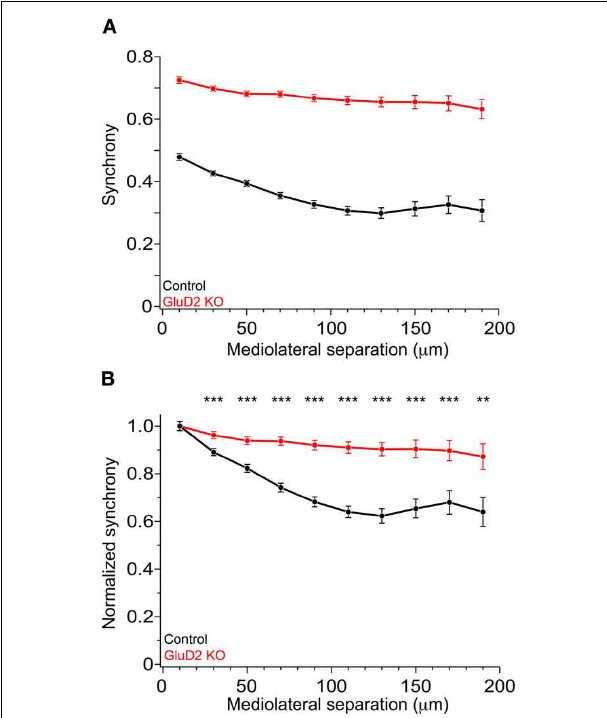
FIGURE 2 | Enhanced synchrony between dendrite pairs of GluD2 KO mice at all the distances of mediolateral separation. (A) Summary graph showing pooled data of synchrony plotted against the mediolateral separation for 1009 dendrite pairs obtained from 33 control mice (black symbols) and for 1064 dendrite pairs from 26 GluD2 KO mice (red symbols). Each data point represents the average of synchrony and error bars indicate SEM. There was significant difference between the two genotypes ( p < 0 . 001 by Two-Way ANOVA). (B) All values of synchrony were normalized by the mean value of the nearest dendrite pairs within the mediolateral separation of 20 μ m. There were significant differences between the two genotypes in all but the nearest pairs ( ∗∗ p < 0 . 01, ∗∗∗ p < 0 . 001 by Two-Way ANOVA and Tukey test), indicating that the degree of decline in synchrony in the mediolateral direction is much smaller in GluD2 KO mice than that in control mice.